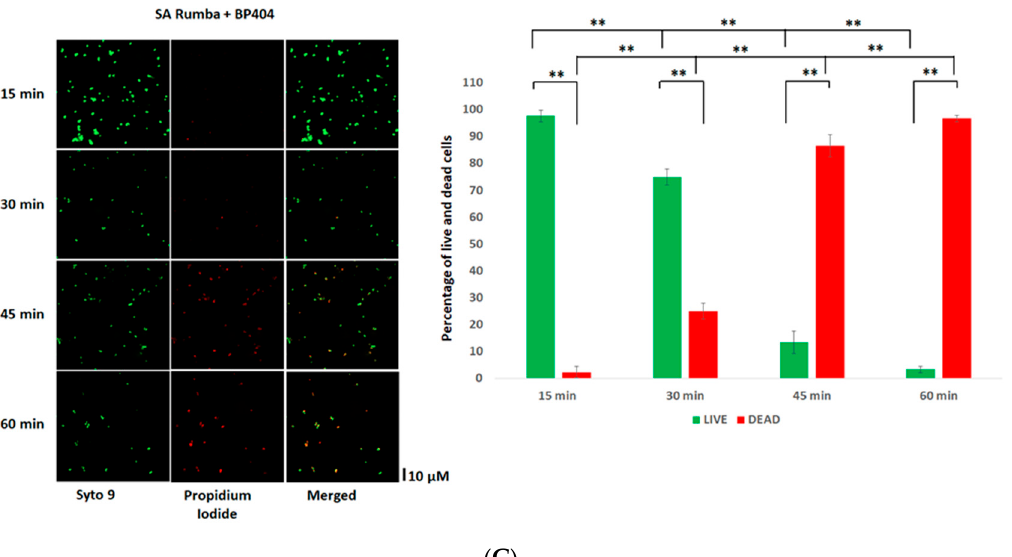
Figure 2. Activity testing of P16-17/100 and BP404 against S. aureus Rumba planktonic cells (SA) Rumba. ( A ) SA cells were treated with bu ff er, and live and dead cells were estimated at various time points. The Syto9 channel shows live cells, and the propidium iodide channel shows dead cells. The merged channel shows both live and dead cells. The percentage of live and dead cells is shown as a graph. ( B ) Microscopic images of P16-17/100-treated SA cells at various time points is shown. The corresponding percentage of live and dead cells is represented as a graph. ( C ) SA cells treated with BP404 at various time points are shown. The corresponding graph showing live and dead cells is represented as a graph. The error bars show the standard deviation. The statistical test of variance was calculated by one-way ANOVA (* p ≥ 0.05; ** p ≤ 0.05). The experiment was performed in tripli- cate.